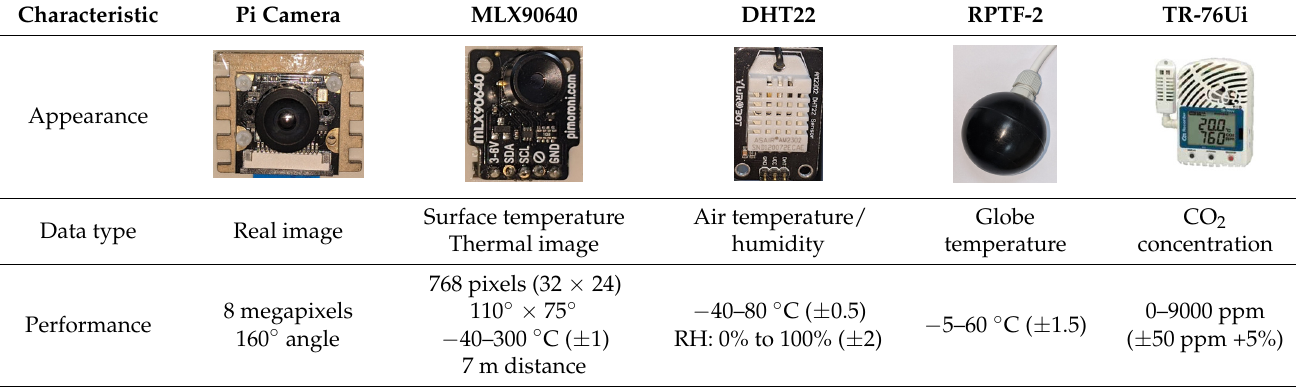
Figure 5. Experimental set-up. Table 3. Experimental outline. Parameter